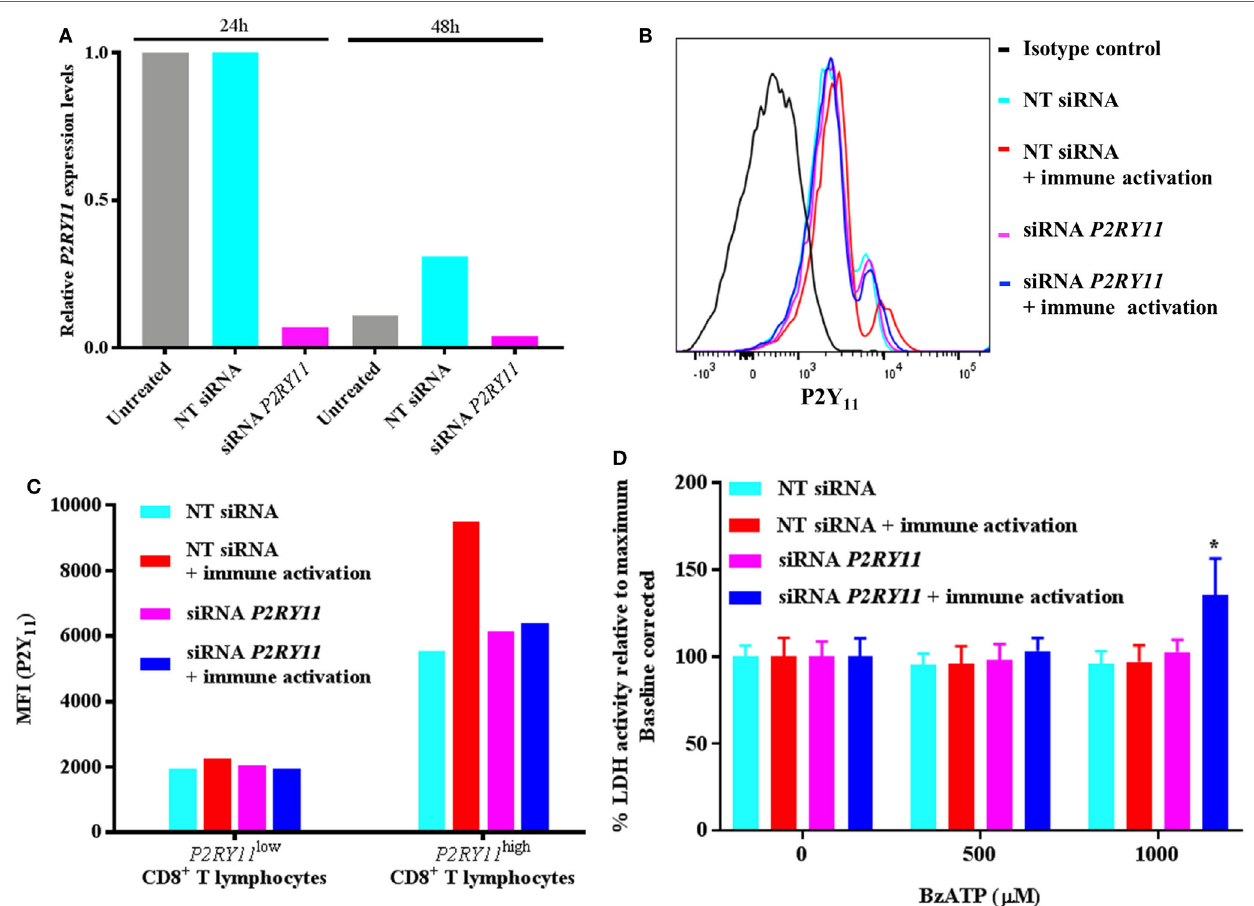
FigUre 4 | P2RY11 silencing in CD8 + T lymphocytes shows increased BzATP-induced cell death following immune activation. (a) Relative P2RY11 gene expression changes 24 and 48 h in CD8 + T lymphocytes left untreated (gray) or after transient transfection with non-targeting (NT) (turquoise) or siRNA targeting P2RY11 (purple). (b) P2Y 11 protein expression measured by flow cytometry count in isotype control (black), NT siRNA (turquoise), NT siRNA immune-activated (red), P2RY11 -silenced (purple), or P2RY11 -silenced immune-activated CD8 + T lymphocytes from a single donor. (c) Mean fluorescence intensity (MFI) from P2Y 11 receptor protein expression measured by flow cytometry on transient transfected CD8 + T lymphocytes. (D) Lactate dehydrogenase (LDH) activity in transiently transfected CD8 + T lymphocytes stimulated 2 h with BzATP. Data are shown as mean ± SEM of maximum induced cell death at 1% Triton X-100 following baseline correction, n = 5–6 from two independent